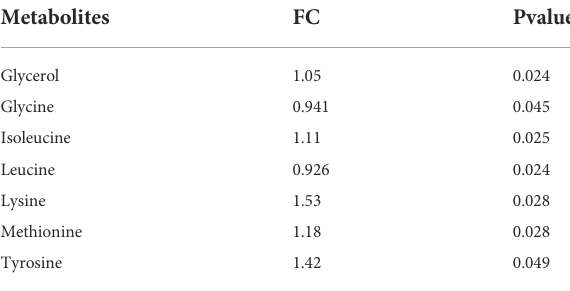
TABLE 5 Signi fi cant plasma metabolites identi fi ed in GBH dietary exposed (GBH, n = 10) as compared to control hens (CT, n = 10) at day 42 (D42).